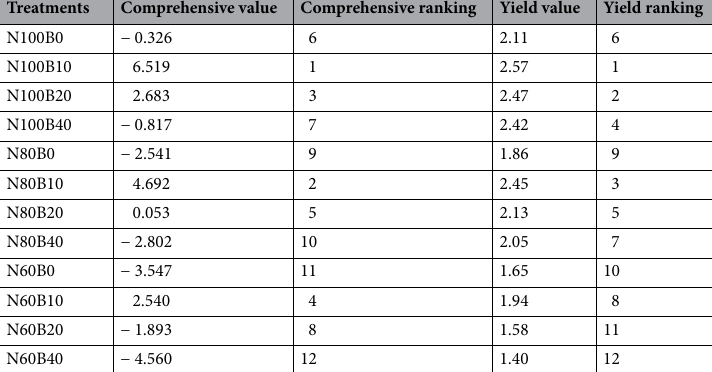
Table 8. Principle analysis of soil fertilization in different treatments.